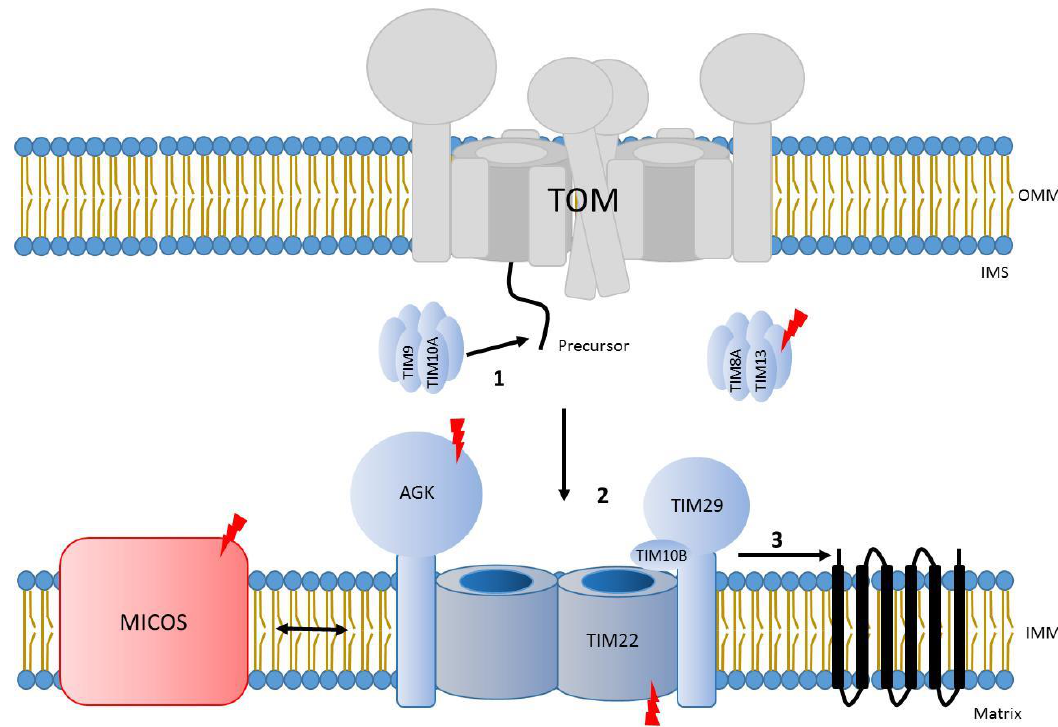
Figure 4. Scheme of insertion of TIM22 substrates in the inner mitochondrial membrane. 1. After crossing the outer membrane through the TOM complex, cargo proteins of the TIM22 translocase are stabilized in the IMS by small TIMs chaperone ring. 2. Small TIMs ring-precursor complex dock to the TIM22 complex and precursors are directed to the twin-pore channel. 3. Precursors are inserted in the lipid bilayer in a sequential mechanism. Interaction with MICOS complex promotes efficient TIM22 mediated import. Lightning Bolt: Subunits with known mutations associated with mitochondrial diseases. OMM, outer mitochondrial membrane. IMS, intermembrane space. IMM, inner mitochondrial membrane.